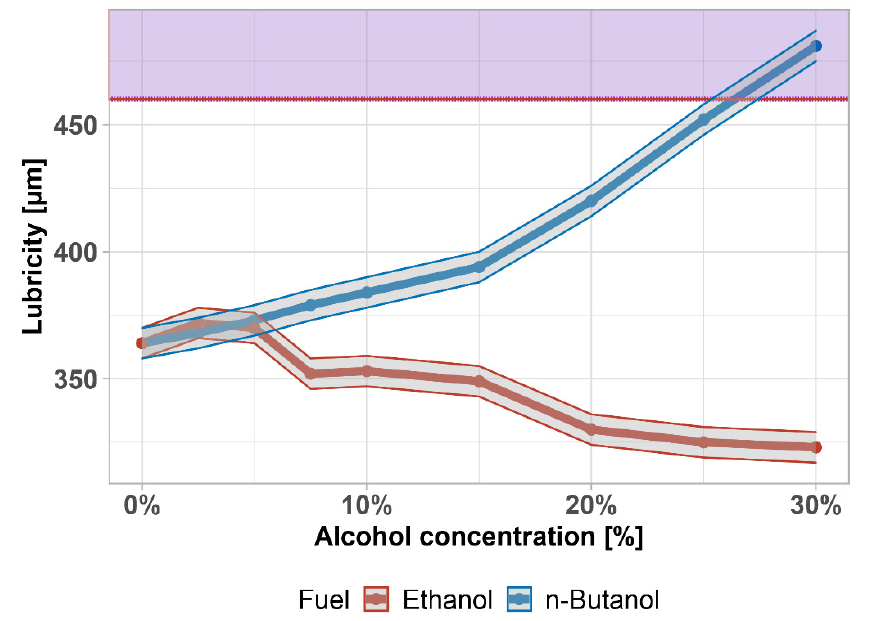
Figure 8. Lubricity of diesel fuel–alcohol mixtures. Purple area highlights exceeding the limit given by the standard.